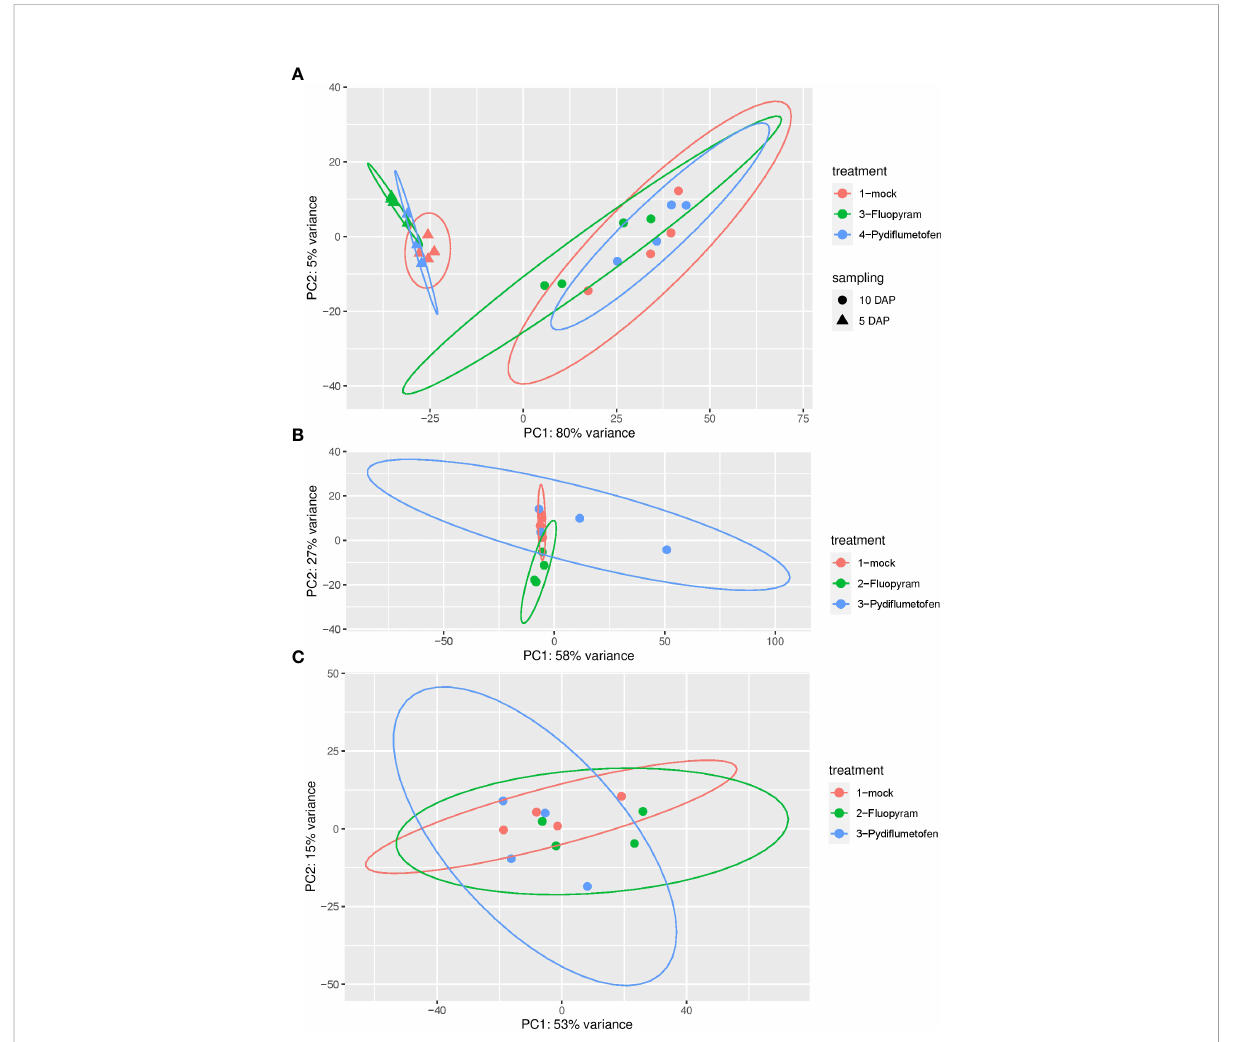
FIGURE 1 Principal coordinate analysis (PCA) of gene expression in soybean seedlings treated with fl uopyram and pydi fl umetofen 5 and 10 days after planting (A) . PCA analysis was also conducted for each time point ( B : 5 DAP; C : 10 DAP).